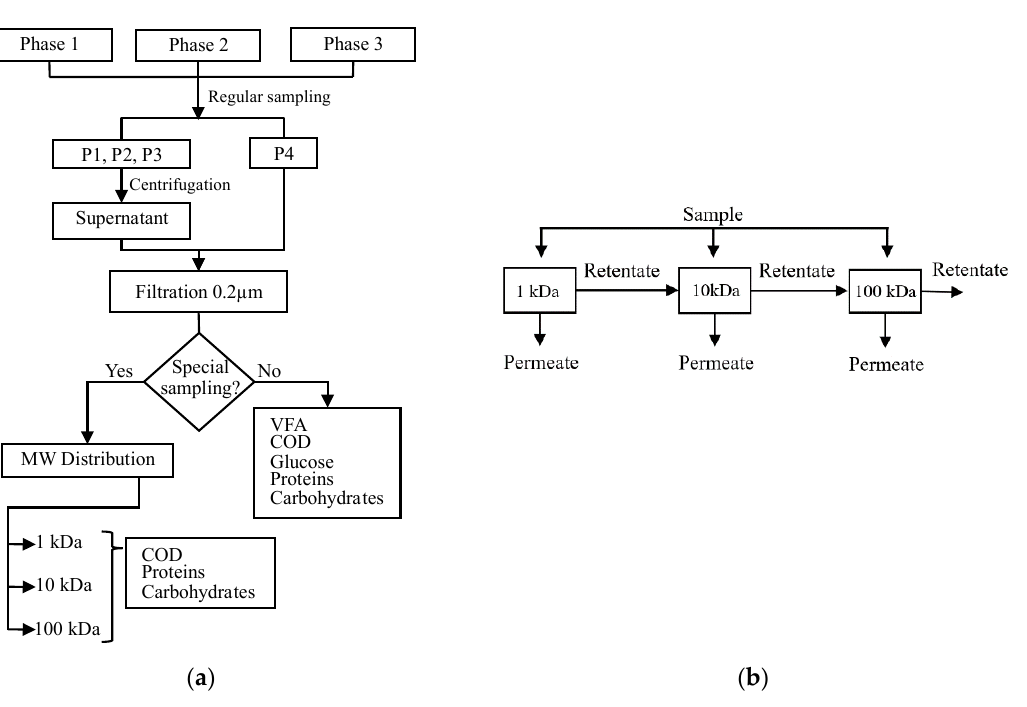
Figure 2. ( a ) Sampling methodology followed during the three phases. ( b ) The parallel configuration of Amicon ® stirred ultrafiltration cells used for soluble microbial product (SMP) molecular weight (MW) distribution.